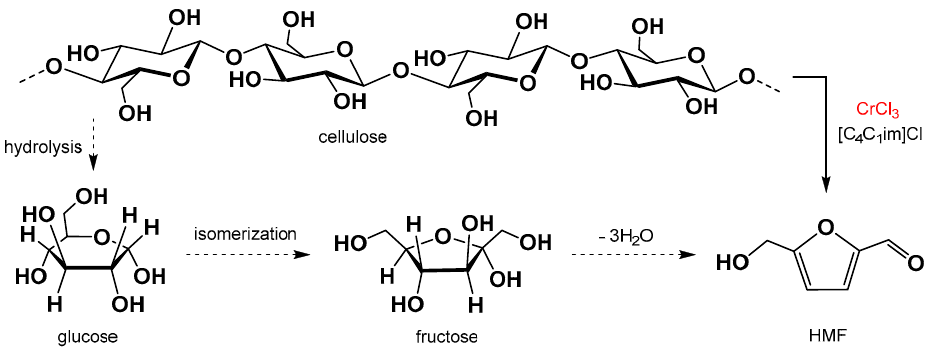
Figure 5. Transformation of cellulose to HMF via glucose and fructose.